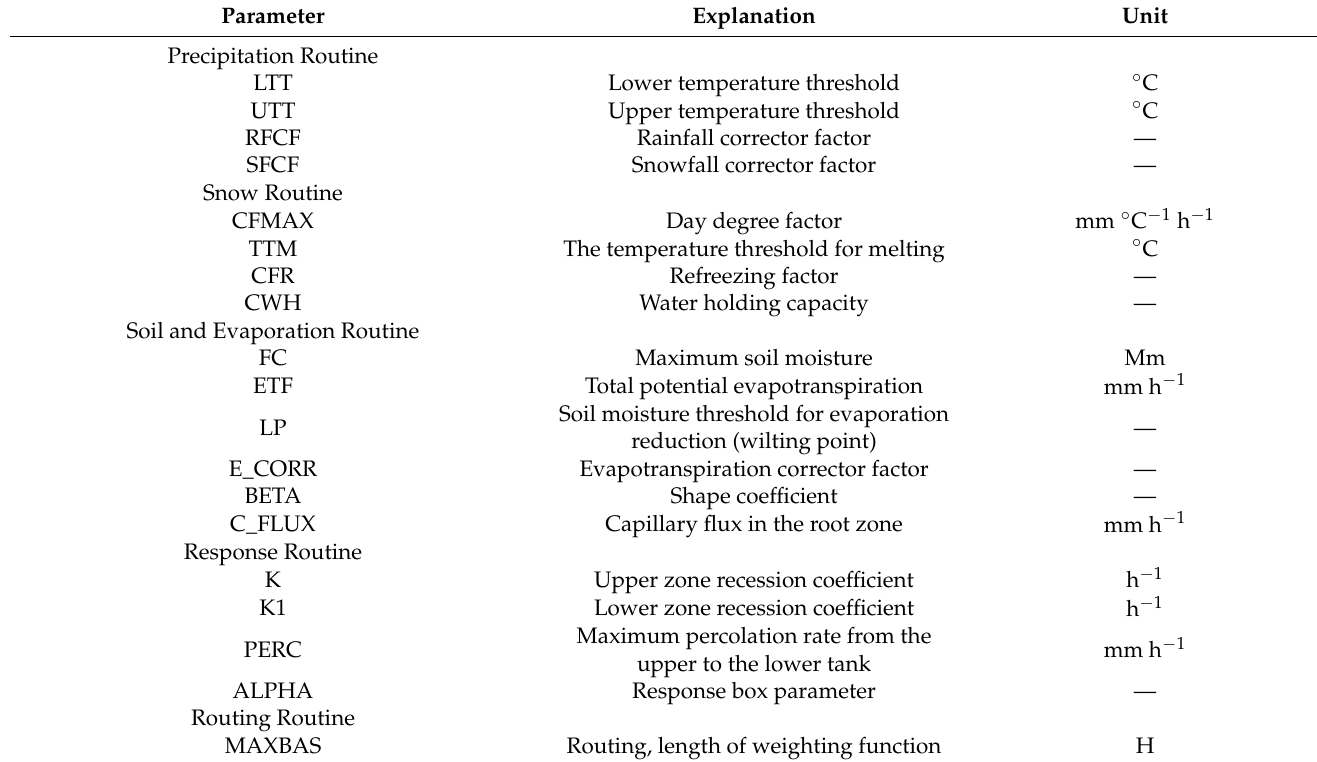
Table 3. Parameters of the HBV model targeted for calibration in this